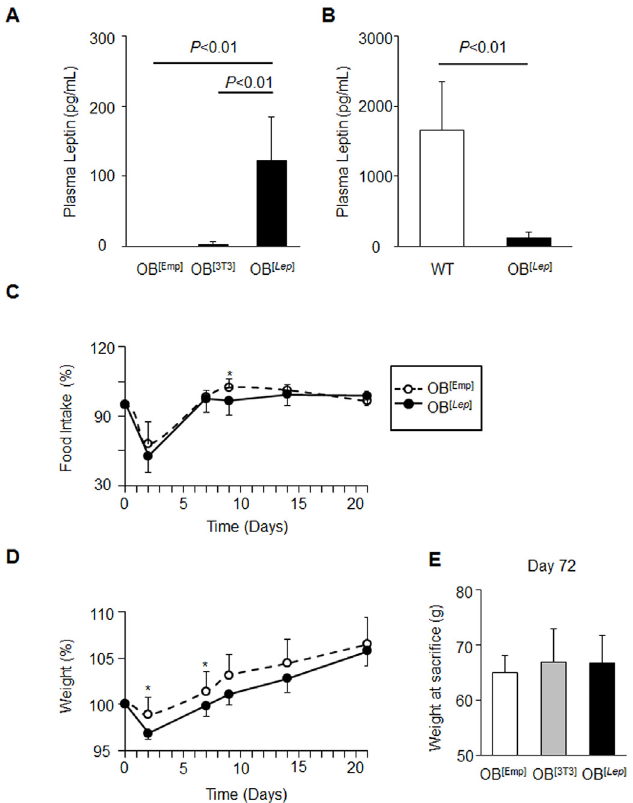
Fig 2. Treatment with leptin-producing encapsulated adipocytes increases plasma leptin and transiently influences food intake and weight. O b/ob mice (n = 7 per group) were injected with encapsulated acellular capsules (OB [Emp] ), encapsulated 3T3-L1 preadipocytes (OB [3T3] ), and encapsulated 3T3 Lep (OB [ Lep ] ) in both visceral fat pads (total 0.6 * 10 6 adipocytes for each cell type). (A) Leptin concentrations in plasma from OB [Emp] (n = 4), OB [3T3] (n = 4), and OB [ Lep ] (n = 7) mice. The leptin ELISA was performed on non-hemolyzed plasma samples. All data are expressed as means ± SD. Significant differences are shown with a black bar and determined by one-way ANOVA followed by Tukey ’ s post hoc test ( P < 0.01). (B) Comparison of leptin concentrations in plasma from OB [ Lep ] (n = 7) and WT mice fed a high fat (HF) diet for 60 days (n = 5). Leptin was analyzed by ELISA, ( P < 0.01, Student ’ s t-test). (C) Average food intake kinetics in OB [Emp] (open circles, n = 6) and OB [ Lep ] (closed circles, n = 7) mice are shown as percent of intake prior to injection. Asterisks show P < 0.05, Student ’ s t-test. Data for OB [3T3] mice is in S1 Fig. (D) Average weight kinetics in same groups of mice. Weight is shown as percent of weight prior to injection (g/g prior to injection x 100). Asterisks show P < 0.05, Student ’ s t-test. (E) Weights at sacrifice (72 days post- treatment, mean ± SD) in same group of